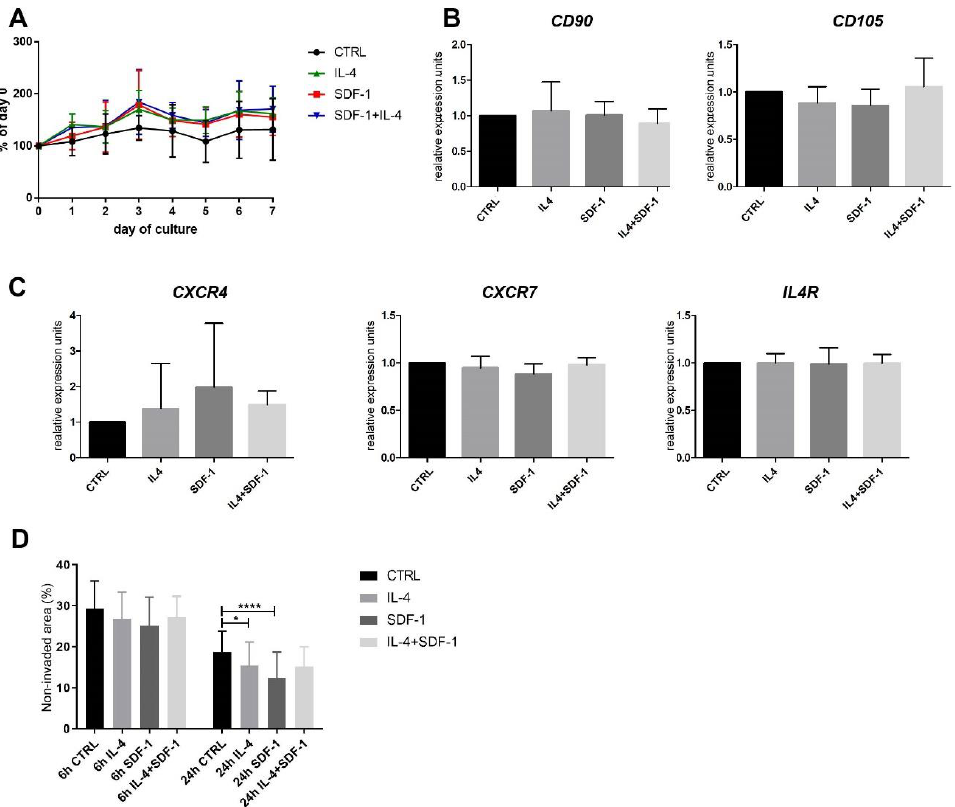
Figure 6. Characterization of hADSCs cultured under control conditions or in the presence of IL-4, SDF-1, or IL-4 and SDF-1. ( A ) Growth curves of ADSCs cultured for 7 days. ( B ) Analysis of the level of mRNAs encoding CD90 and CD105. Expression was related to the levels observed in control cells and normalized to mRNA encoding β-actin, i.e., ACTB. ( C ) Analysis of the level of mRNAs encoding CXCR4, CXCR7, and IL4R. Expression was related to the levels observed in control cells and normalized to mRNA encoding ACTB. ( D ) In vitro migration assay—hADSCs were scratched from the culture dish and the area which was not invaded by migrating cells was presented (6 h and 24 h) as the proportion (%) of the whole area photographed. For each experimental group n ≥ 3. Data are presented as mean ± SD. Data have been analyzed using Kruskal-Wallis test. * p < 0.05, **** p < 0.0001. Next, we assessed how the IL-4 or SDF-1 or both of them impact the ability of hADSCs to initiate myogenic differentiation in vitro. We assessed the expression of mRNA encoding mesoderm marker, mesogenin (data not shown), and adhesion proteins CD9, M-cadherin (CDH-15), and V-CAM1 (data